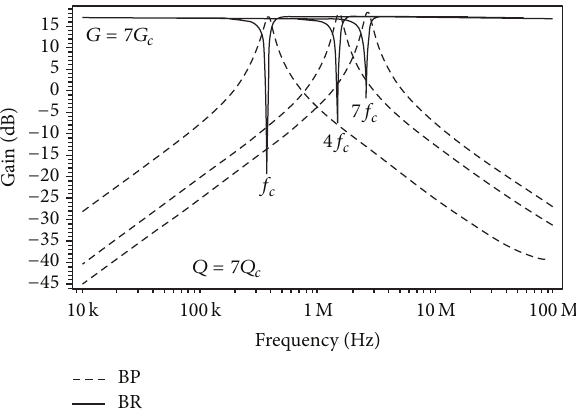
Figure 8: Pole frequency programming of BP and BR.